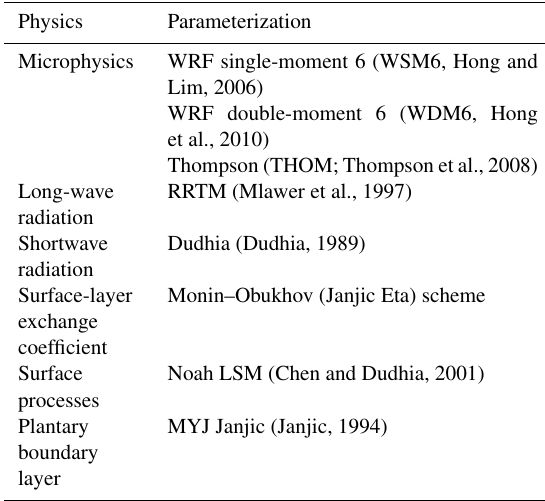
Table 1. The WRF parameterizations